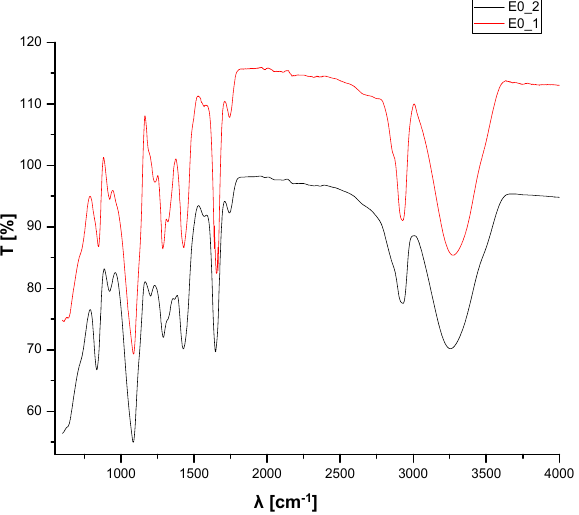
Figure 8. Spectra from the FTIR spectroscopy of the E0_1 and E0_2 compositions.